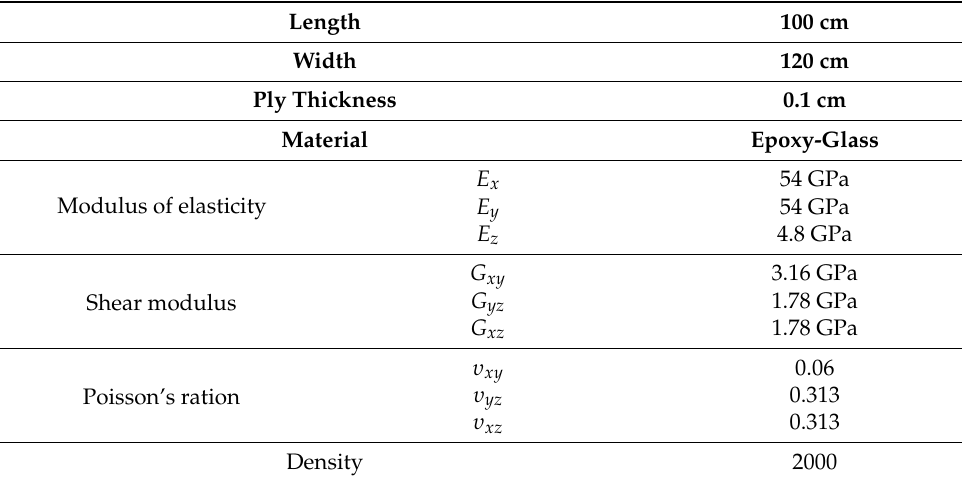
Table 2. Material properties and dimensions of the laminated composite.